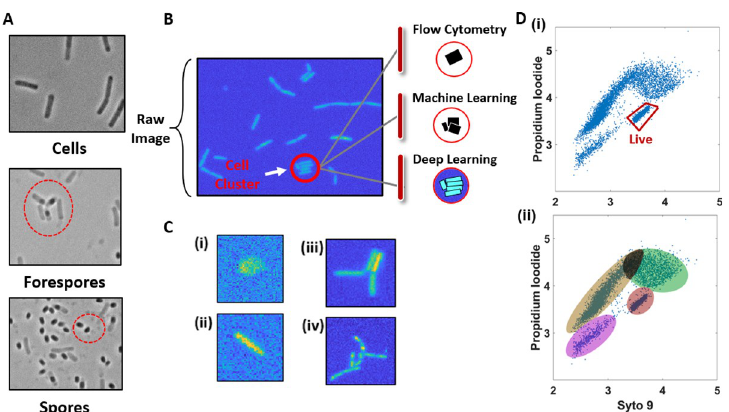
Fig 1. Classifying and counting bacterial sub-populations. (A) Examples of B. subtilis cells, forespores and spores captured on microscope images, identified manually in prior work. (B) “Raw” or unprocessed fluorescence microscopy image of B. subtilis cells during vegetative growth. (C) Examples of various cell clusters found on fluorescent microscope images (i. Artifact (cell debris, impurity), ii. single cell, iii. four-cell cluster, and iv. ten-cell clusters.). (D) Flow cytometry output fluorescence data for viability assay of B. subtilis cells. (i) Gated region contains signal from live cells. Data presented in log (RFU) scale. (ii) Clusters of data on flow cytometry output from (Di) that likely associate with different cell states (vegetative, spore) but are difficult to determine from the FACS data.